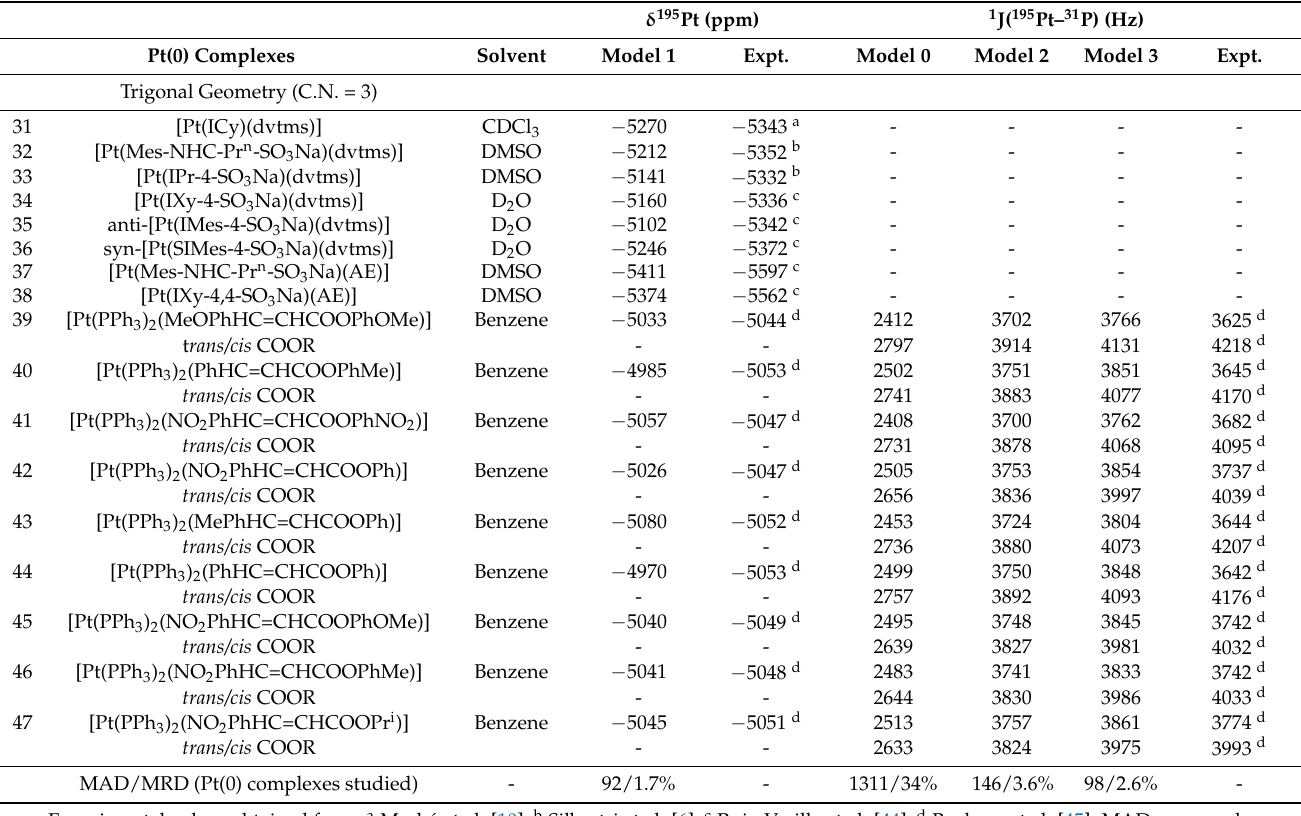
Table 3. Calculated δ 195 Pt in ppm, and 1 J( 195 Pt– 31 P) in Hz, for the Pt(0) complexes used in the validation of the proposed empirical models.